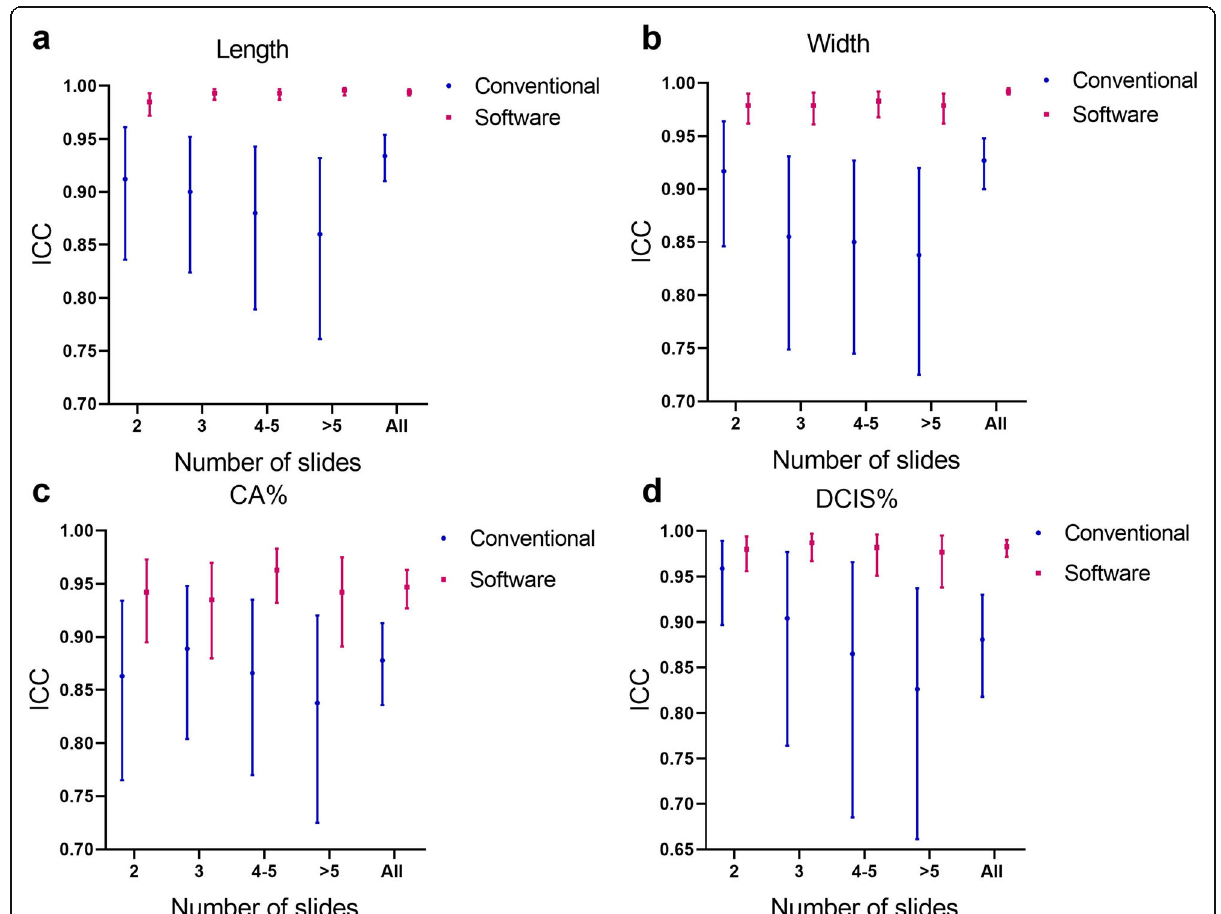
Fig. 5 Comparison of tumor bed evaluation consistency between the software-assisted and conventional method by five pathologists. a-d Comparison of the consistency between the conventional methods and software-assisted methods in evaluating tumor bed length diameter, width diameter, percentage of tumor cells in tumor bed (CA%) and percentage of ductal carcinoma in situ (DCIS%).